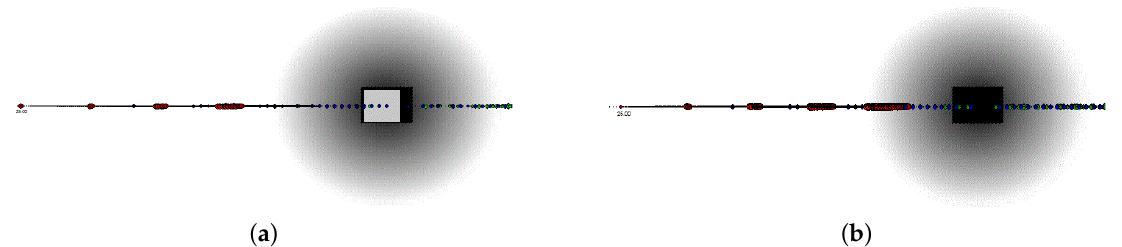
Figure 4. Improving safety by object enlargement while predicting the object location. An obstacle, represented at a distance of about 30 m, is moving on the vehicle path in the same direction of the vehicle. ( a ) represents the position of the object at time T = T 0 in white, and its position after 20 ms, i.e., at time T = T 0 + 20 ms, in black. As the object travels only 0.8 m between the two frames, we represent all intermediate locations as occupied. ( b ) shows the corresponding grid map generated by our system. Gray tones are used to represent the different probability of the object of being in each location, i.e., when the tone is darker the danger for the vehicle is